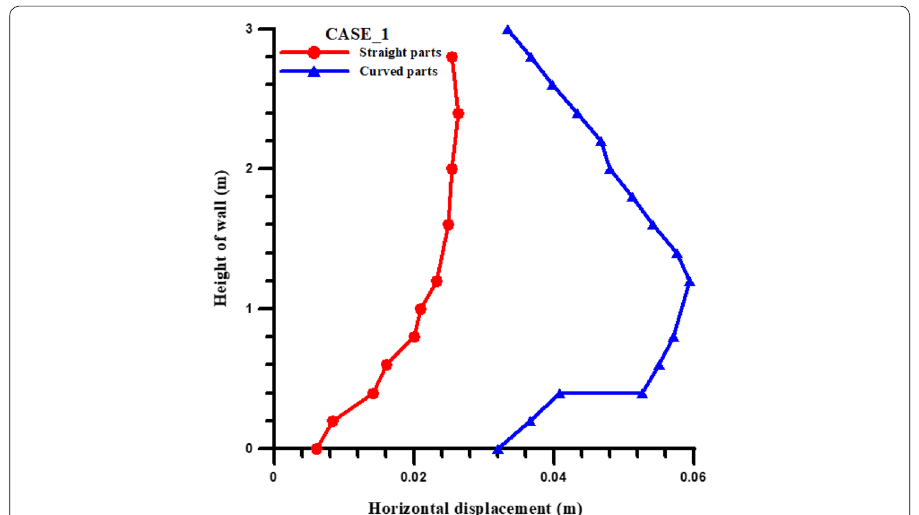
Fig. 11 Horizontal displacement comparison of straight and curved parts for Case 1